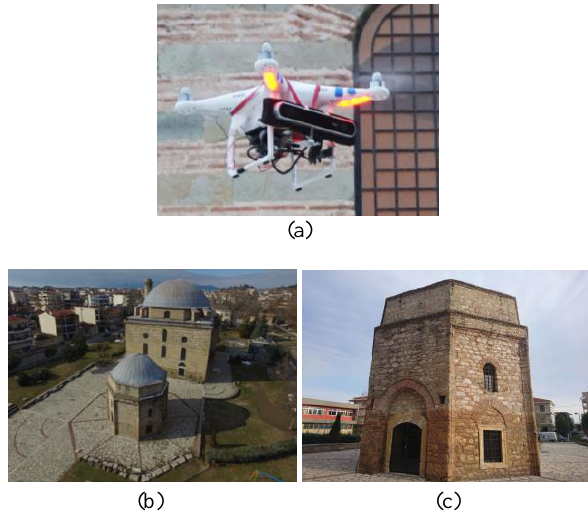
Figure 2. (a) Our custom-made configuration with a ZED camera mounted on a DJI Phantom 2 (b) and (c) the turbe in Trikala, Greece.